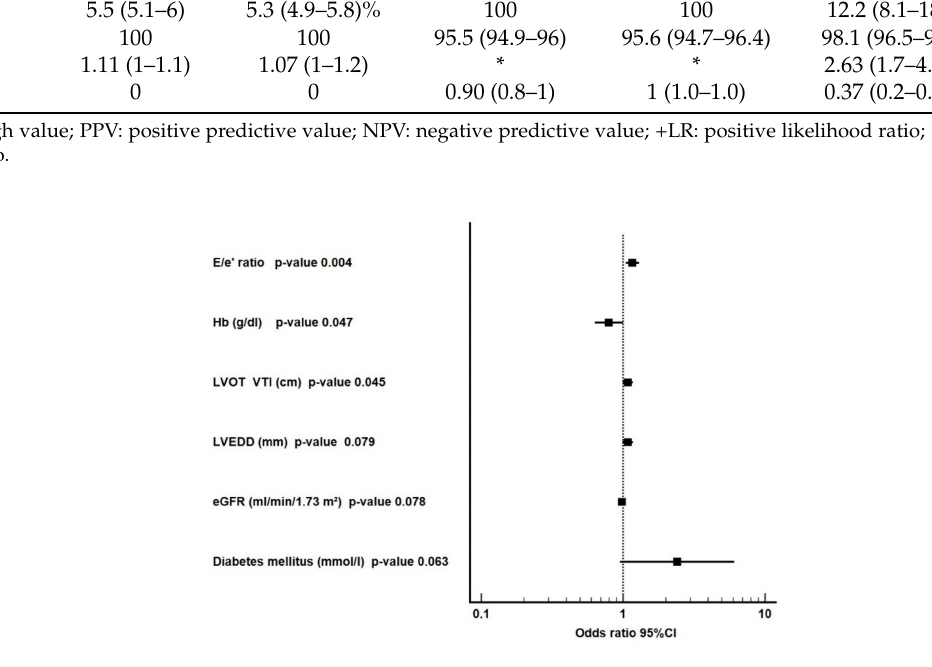
Figure A1. Forest plot for HFR predictors at 6 months. Point estimates represent the multivariable odds ratio for HFR after six months; whiskers indicate a 95% confidence interval